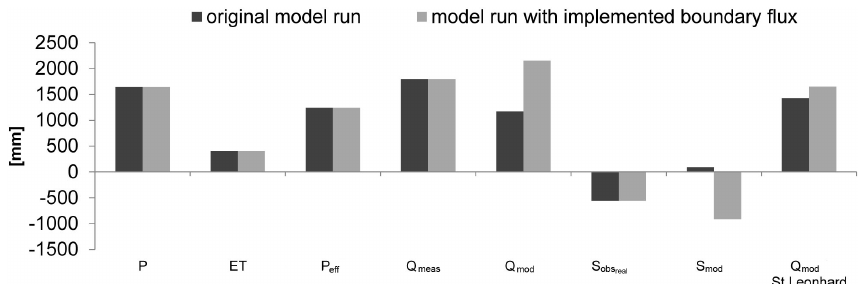
Fig. 17. Water balance components for subbasin K¨onigsseetal and modeled runoff for St. Leonhard – annual sums 2007. Results for orig- inal model run and model run with implemented boundary flux ( P =precipitation, ET=evapotranspiration; P eff =effective precipitation, Q obs =measured runoff, Q mod =modeled runoff, S obs =observed storage, S mod =modeled